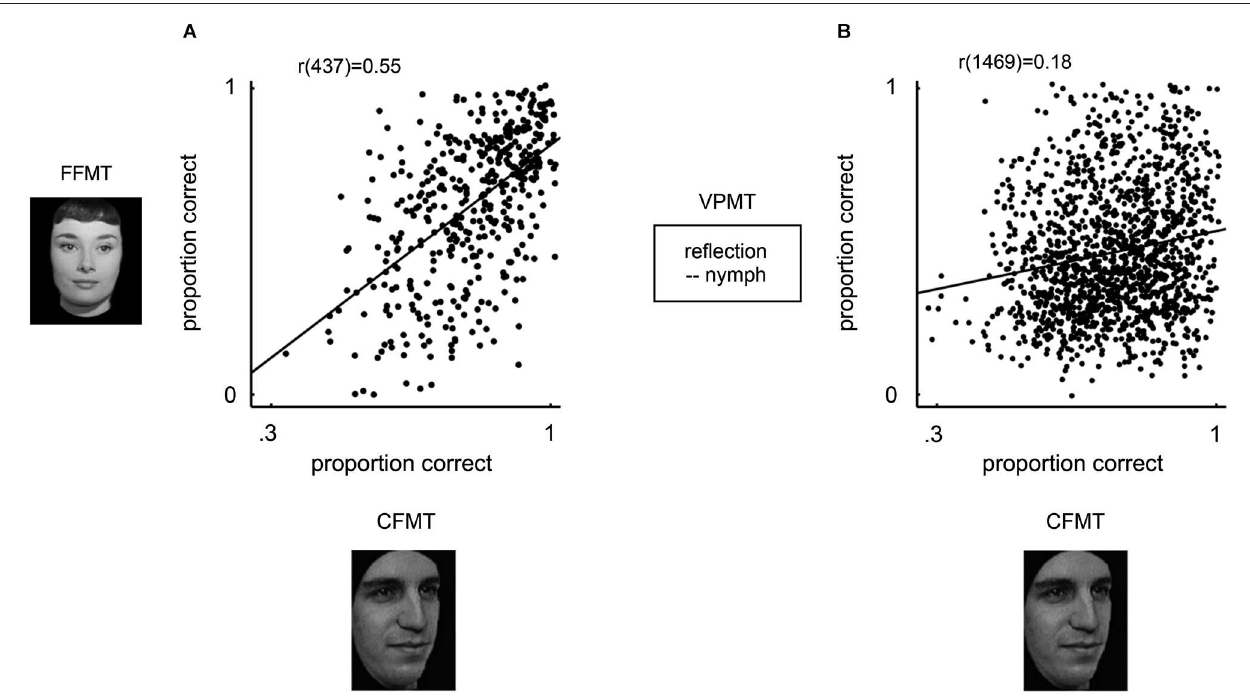
FIGURE 3 | Specificity of face recognition ability (Wilmer et al., 2012) . Face recognition performance (x axis, Cambridge Face Memory Test (CFMT)) is plotted against famous face recognition performance (y axis, graph A , Famous Faces Memory Test (FFMT)) and verbal recognition performance (y axis, graph B , Verbal Paired-associates Memory Test (VPMT)). FFMT and CFMT are very different tests. FFMT measures the ability to name faces stored incidentally in memory over months or years of cultural